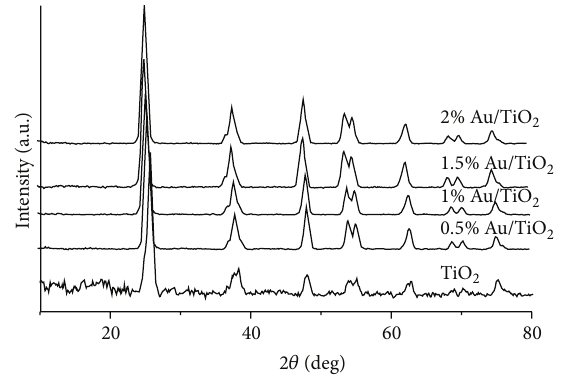
Figure 1: XRD patterns of the prepared photocatalysts.